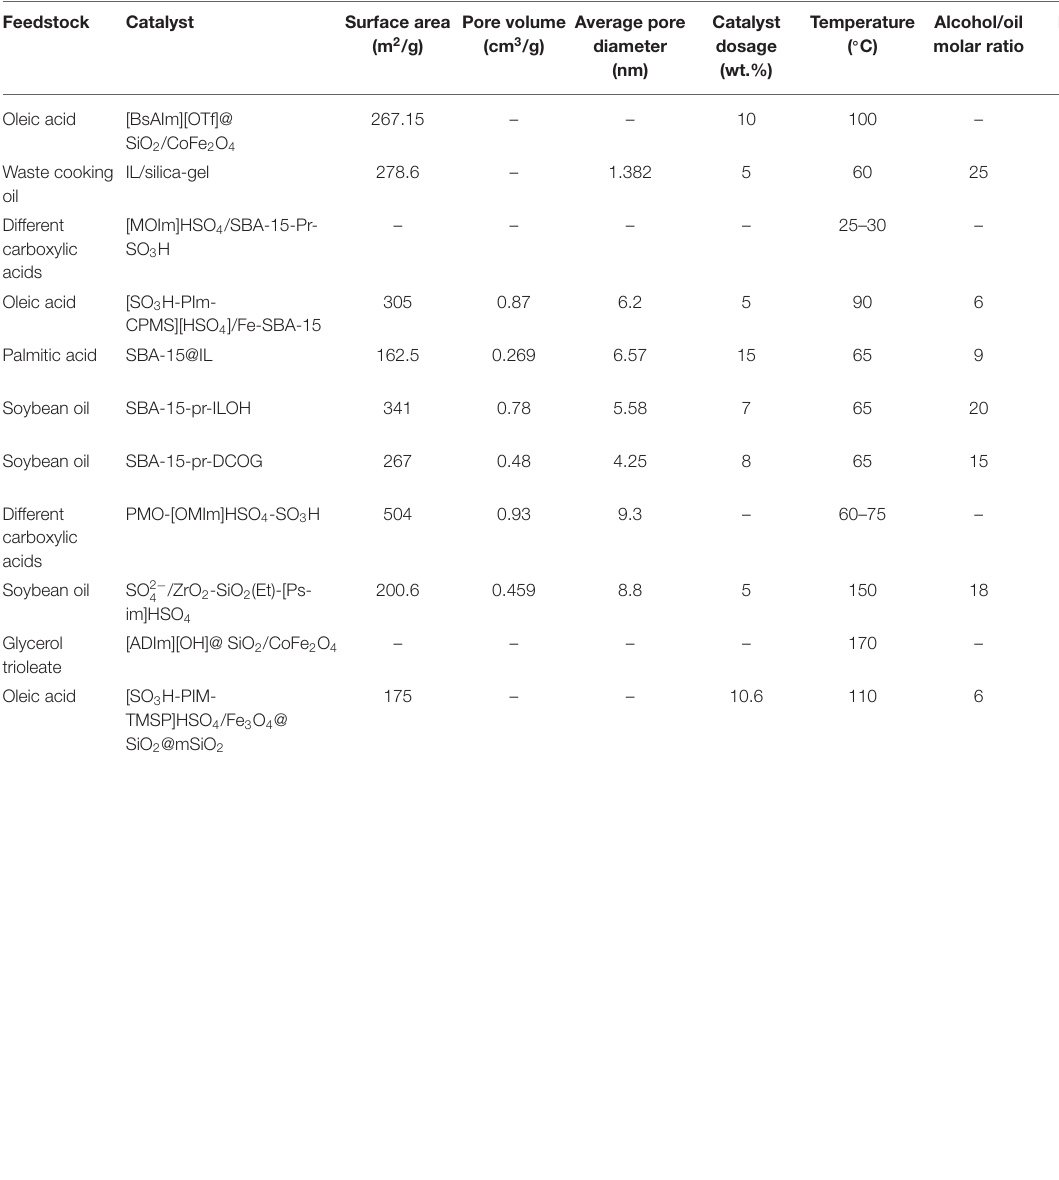
TABLE 1 | Supported ILs on silica-based